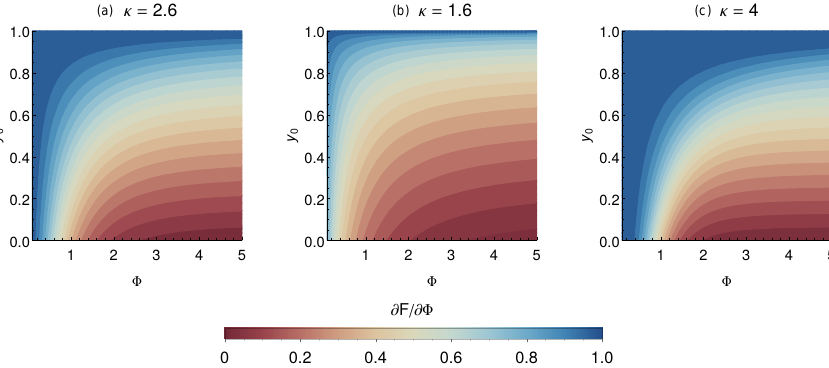
Figure 3. The sensitivity ∂F/∂(cid:56) under varying y 0 , for κ = 2.6 (left panel, similar to the original Budyko framework if y 0 = 0), κ = 1.6 (center panel) and κ = 4 (right panel). Blueish colors denote high and reddish colors low sensitivity.